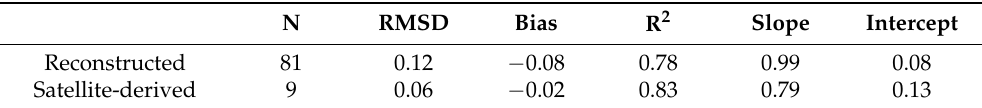
Figure 8. Standard deviation of chlorophyll-a concentration computed from the complete dataset: ( a ) satellite-derived; ( b ) network reconstructed.